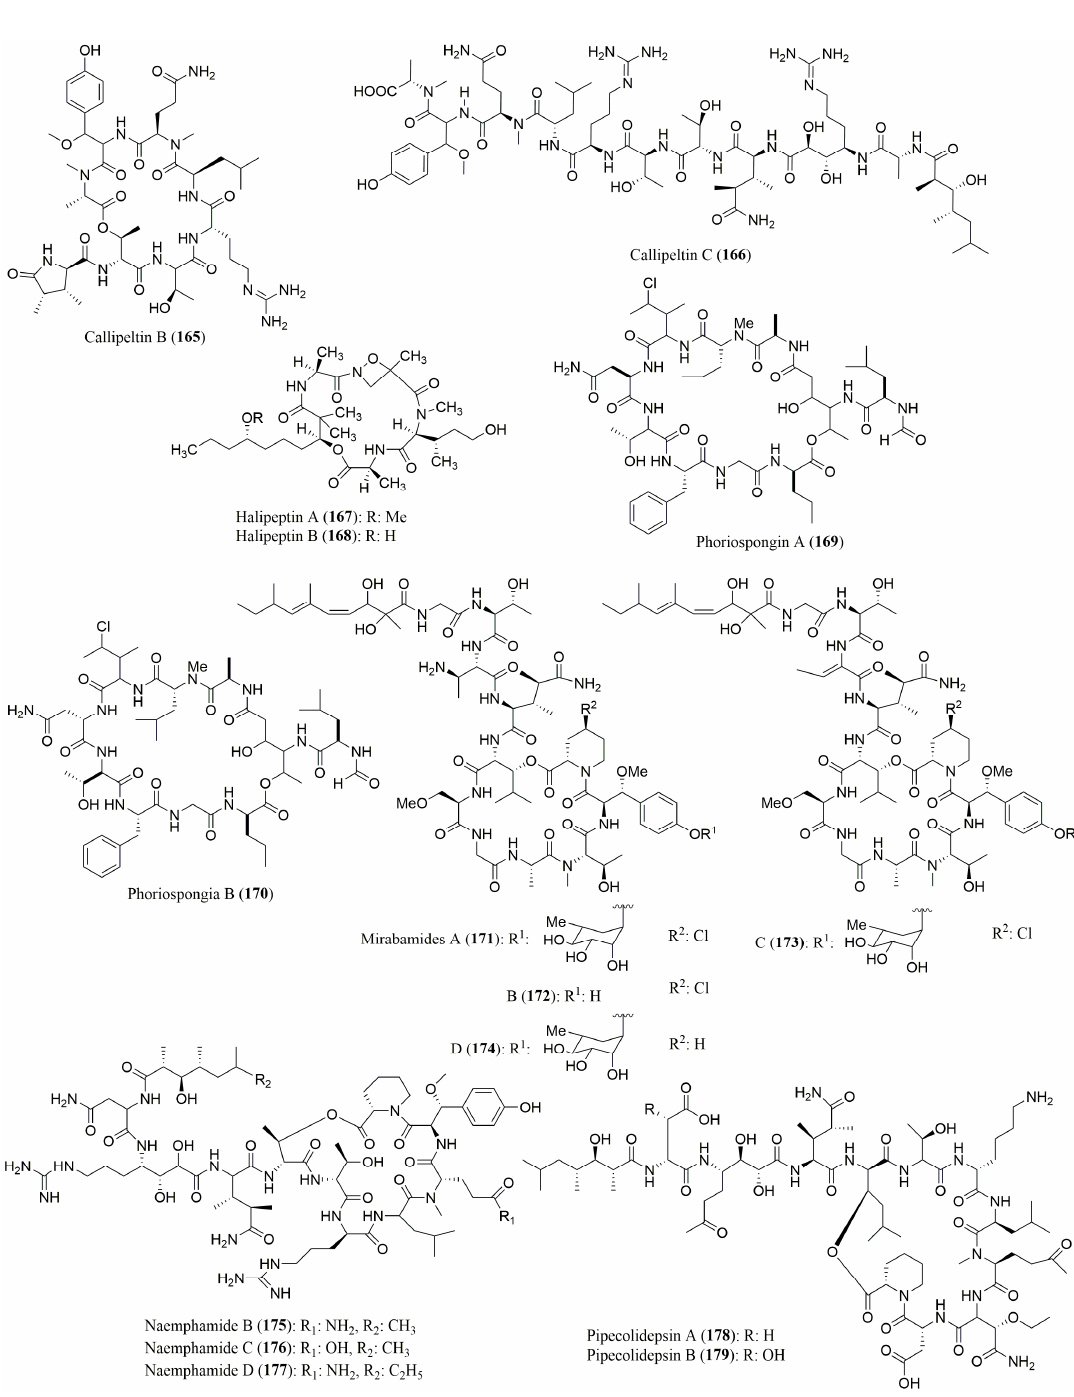
Figure 12. Structure of cyclic depsipeptides 165 – 179 , isolated from marine sponges.